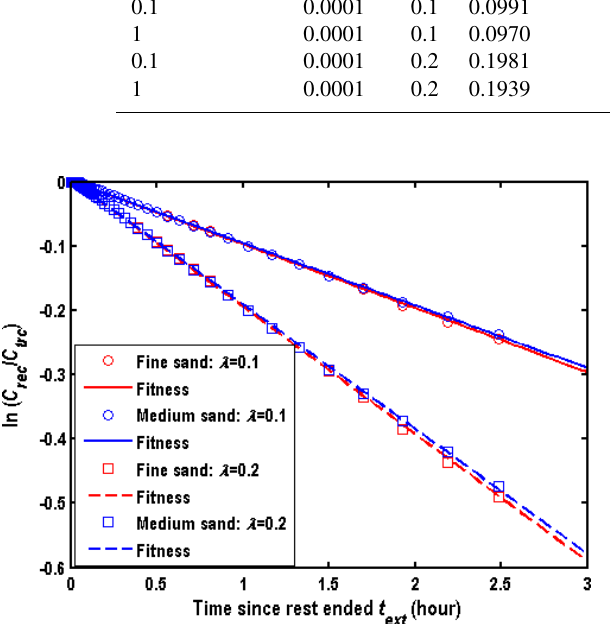
Figure 9. Fitness of ln (cid:2) C rec /C tra (cid:3) ∼ t ∗ produced by the numerical solution of this study with the first-order reaction in the different porous media.